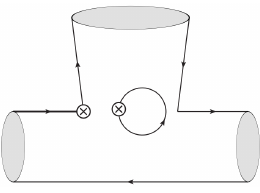
Figure 14 . P 0 diagram, the Fierz transformation of P